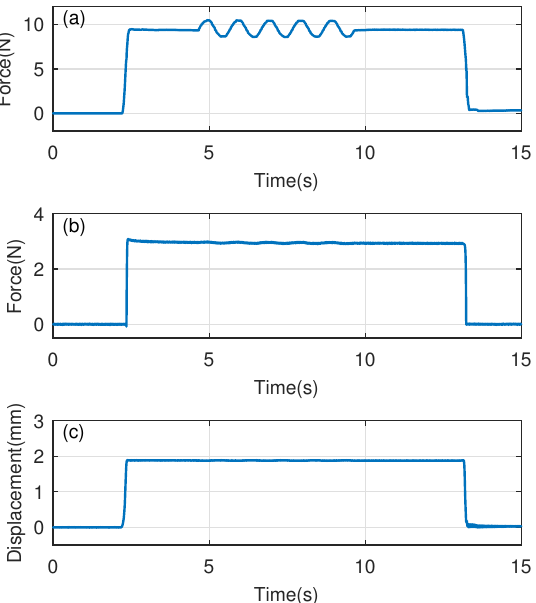
Figure 9. Test result of disturbance rejection during the environmental interaction. ( a ) The force applied to the input end; ( b ) The force on the end-effector; ( c ) Displacement of the